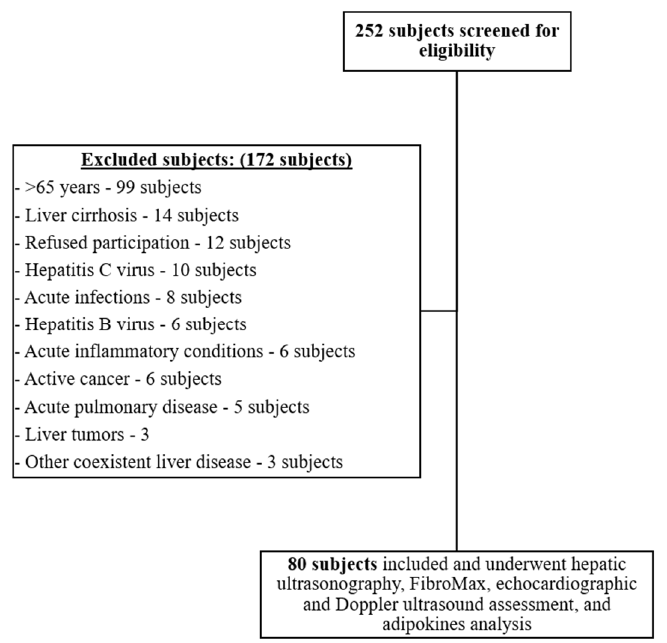
Figure 1. Flow diagram outlining the enrollment process of included and excluded participants. Table 1. General characteristics of included